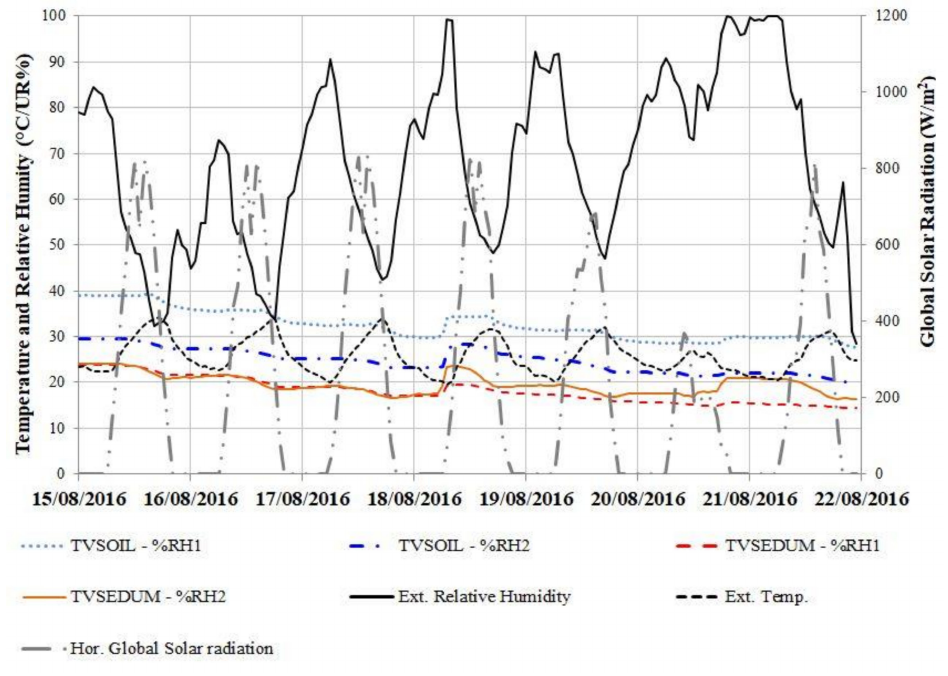
Figure 9. Internal moisture content of growing media during the week from 15–21 August, 2016 with two different roof solutions (TVSOIL and